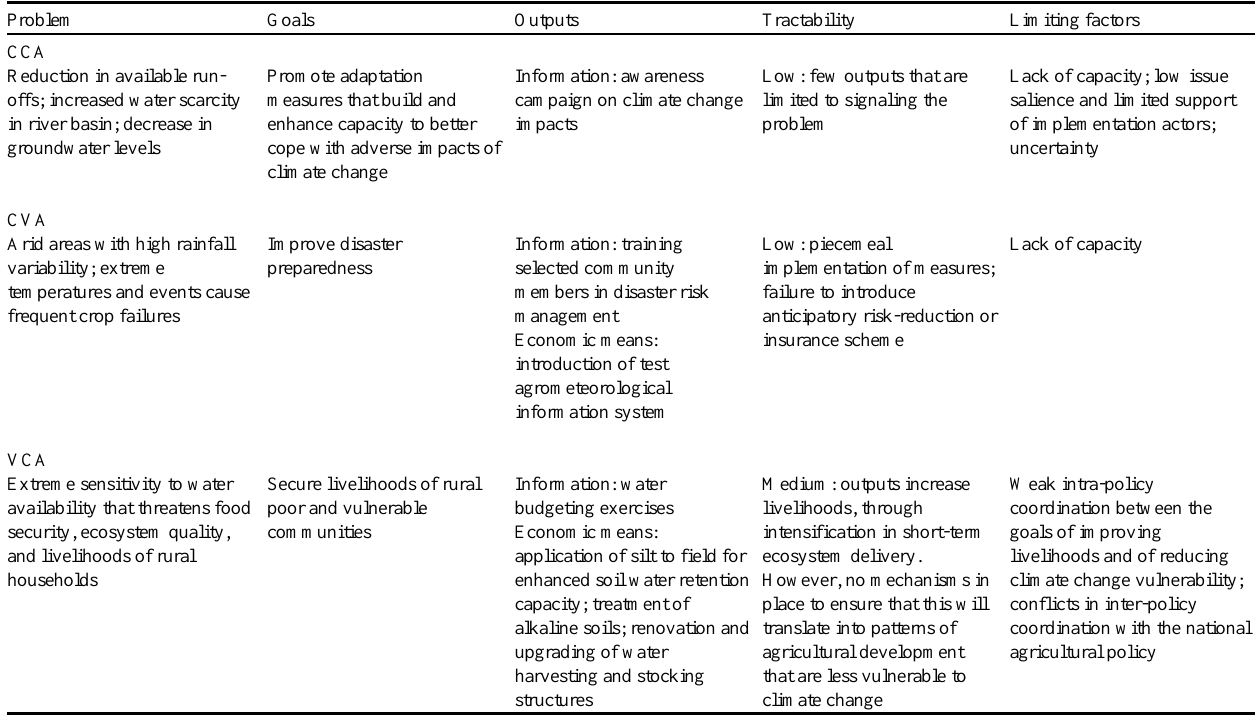
Table 3. Summary of V&A program and analysis of results.